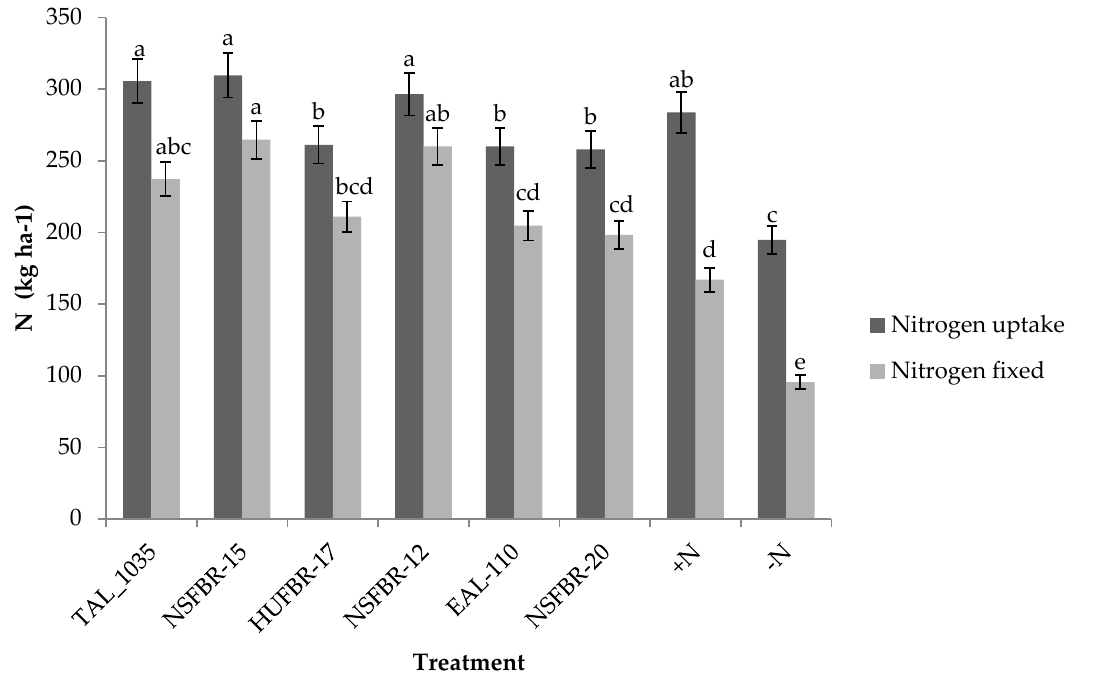
Figure 3. Total nitrogen uptake and nitrogen fixed by faba bean inoculated with different rhizobium strains.